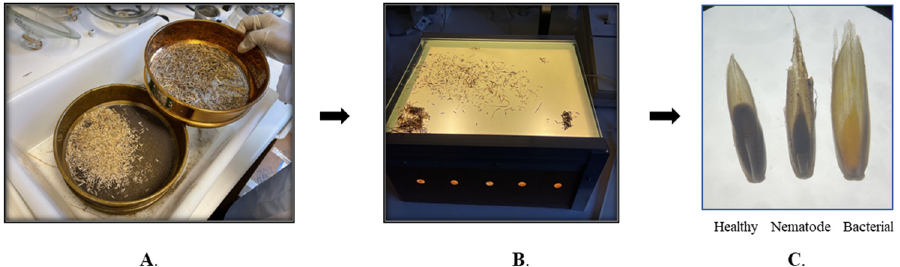
Figure 7. ( A ) Separation of heathy seeds and those with galls from ryegrass husk using different size of sieves, ( B ) light box used for identification and differentiation between infected galls and healthy seeds, ( C ) healthy seeds, nematode gall, and bacterial gall.